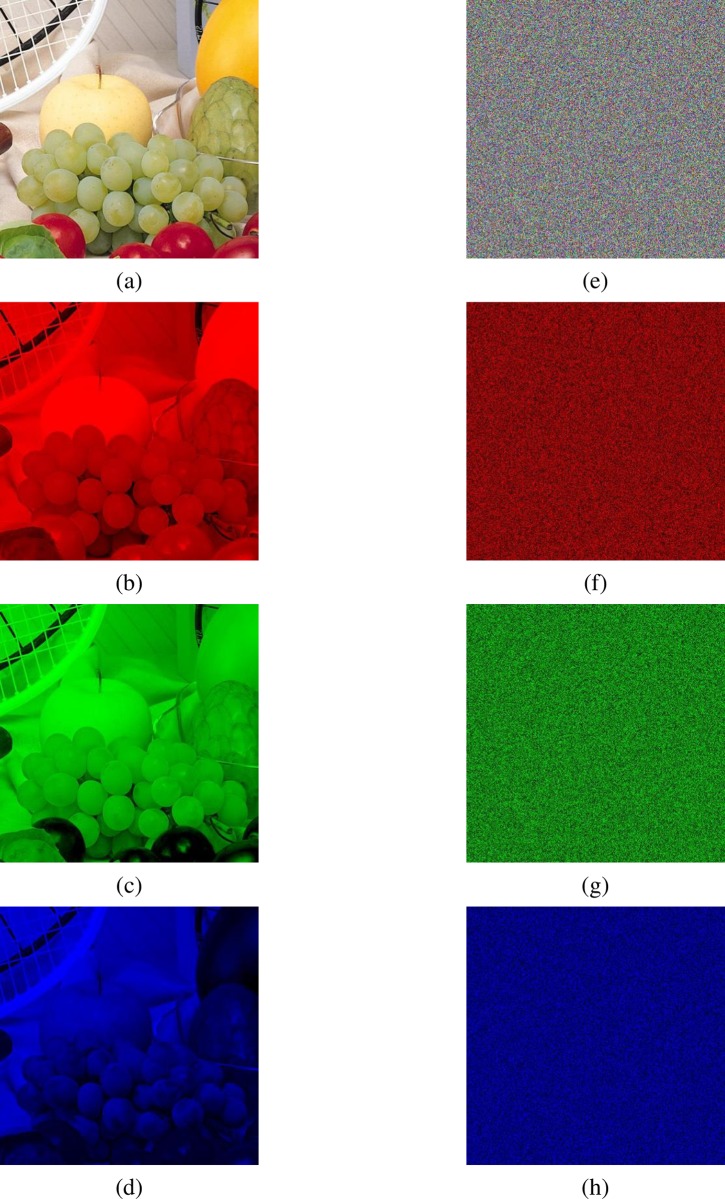
Plain and encrypted layer wise images of Fruits.(a) plain Fruit image. (b) Red component. (c) Green component. (d) Blue component. (e) Encrypted Fruit image. (f) Encrypted Red component. (g) Encrypted Green component. (h) Encrypted Blue component.